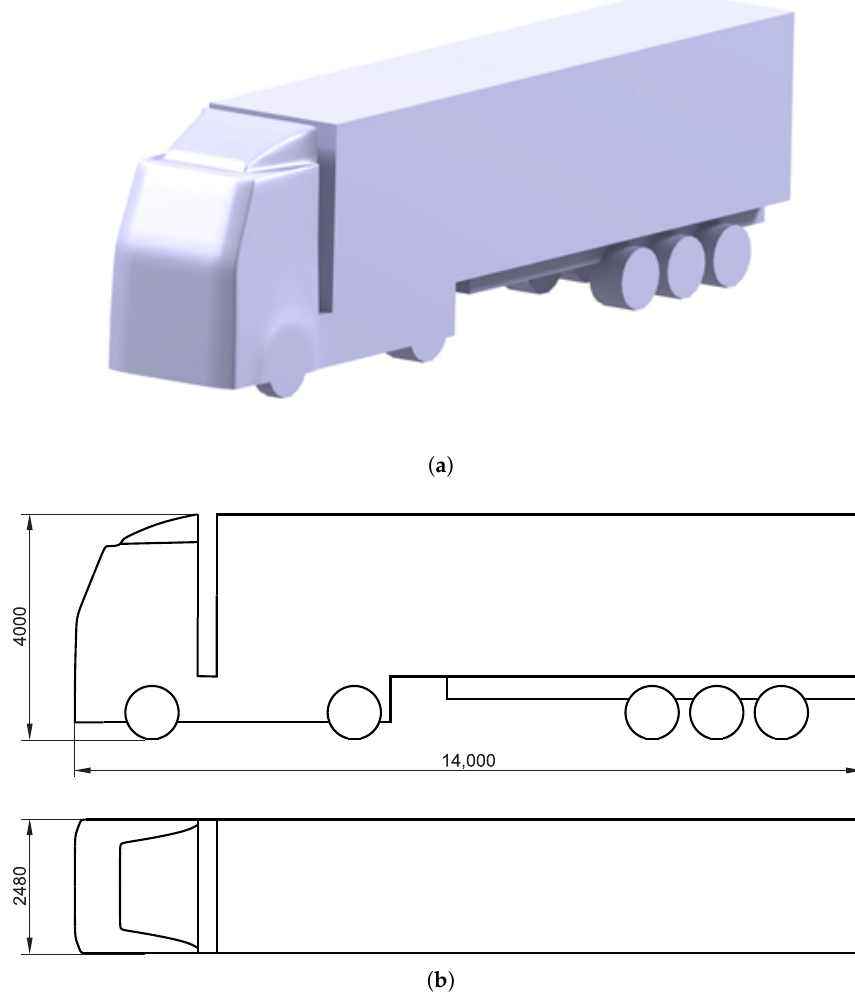
Figure 3. ( a ) Isometric view of the truck model geometry ( b ) Nominal dimensions of the truck